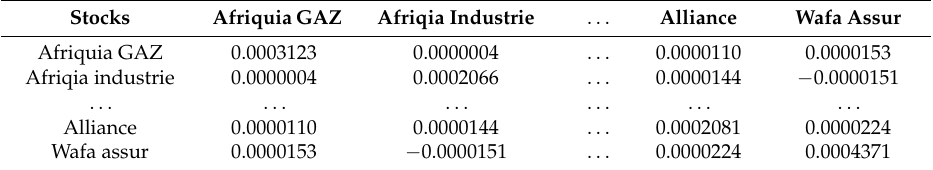
Table produced on Excel under VBA by the authors.